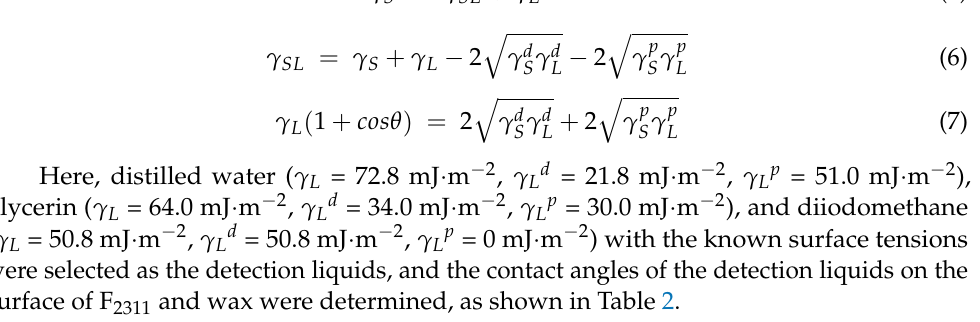
Table 2. The contact angles of the detection liquids on the surface of the coating materials. Detection